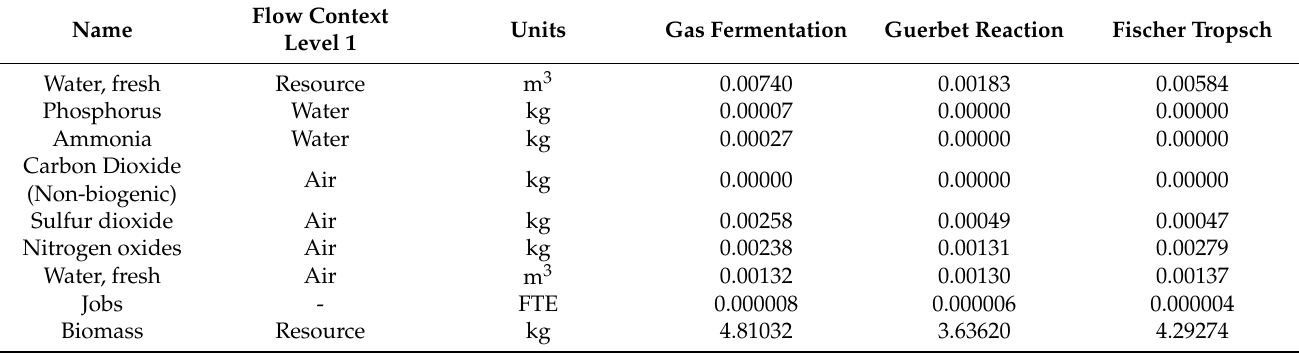
Table A4. Elementary flows for each technology per dollar produced of woody-based